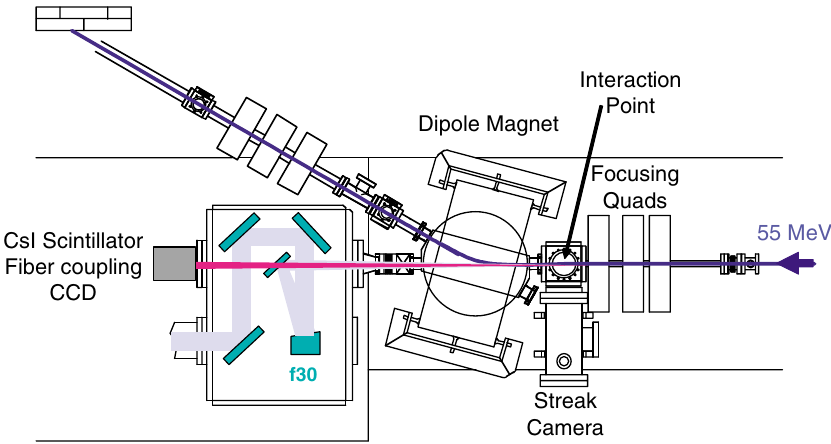
FIG. 1. (Color) Schematic of the interaction region for the PLEIADES Thomson x-ray